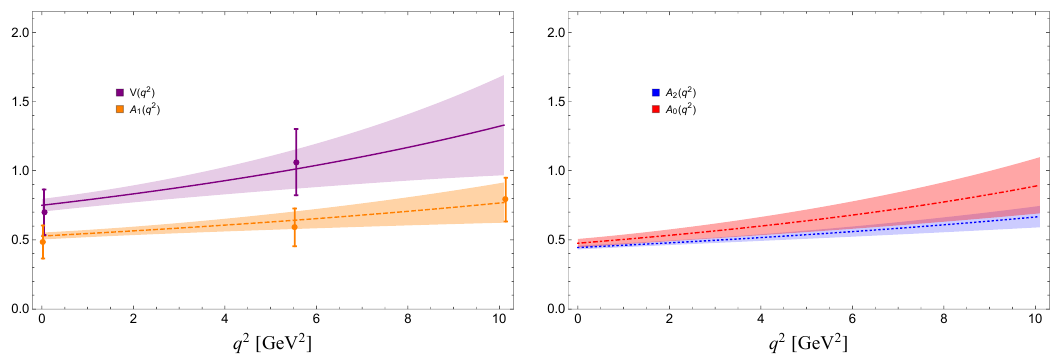
Figure 12 . Final predictions for B c ! J= form factors obtained by extrapolating 3ptSR results to higher q 2 regions using the BCL parametrization.